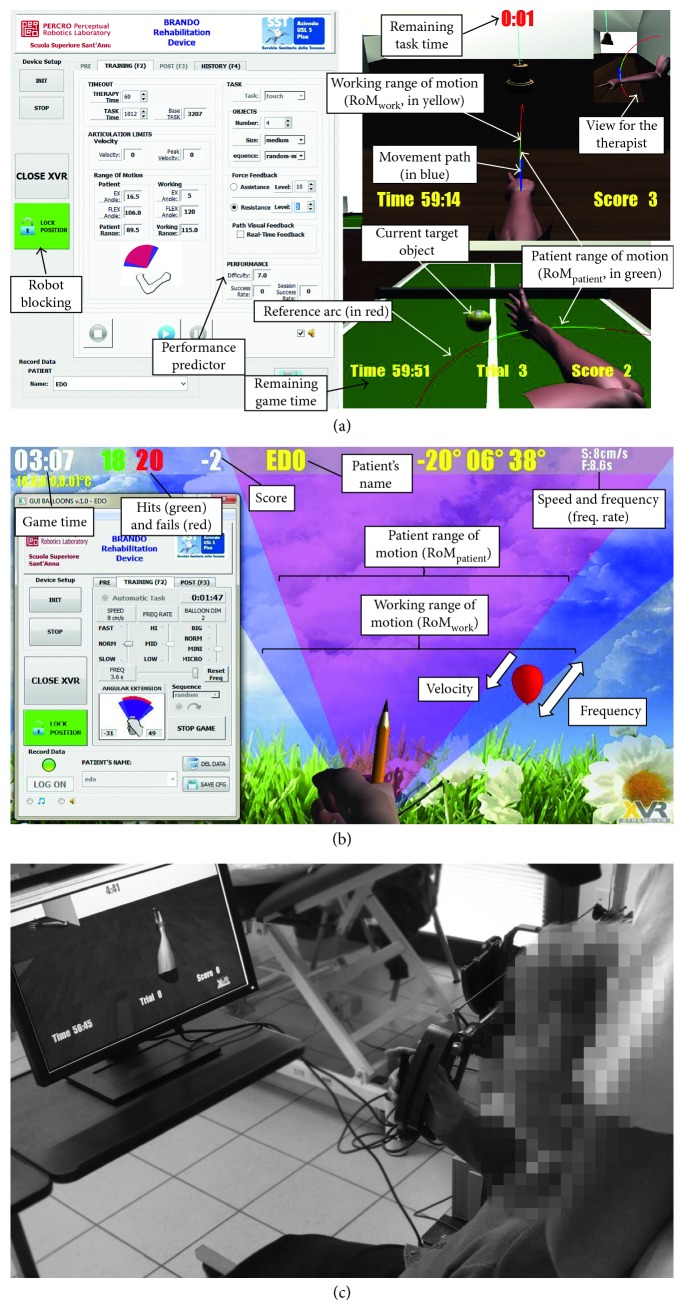
Three views of the full system with the Therapist GUI console and the gaming scenarios with different implemented tasks for the training. (a) FE movements; (b) PS movements; (c) a patient performing with the system.